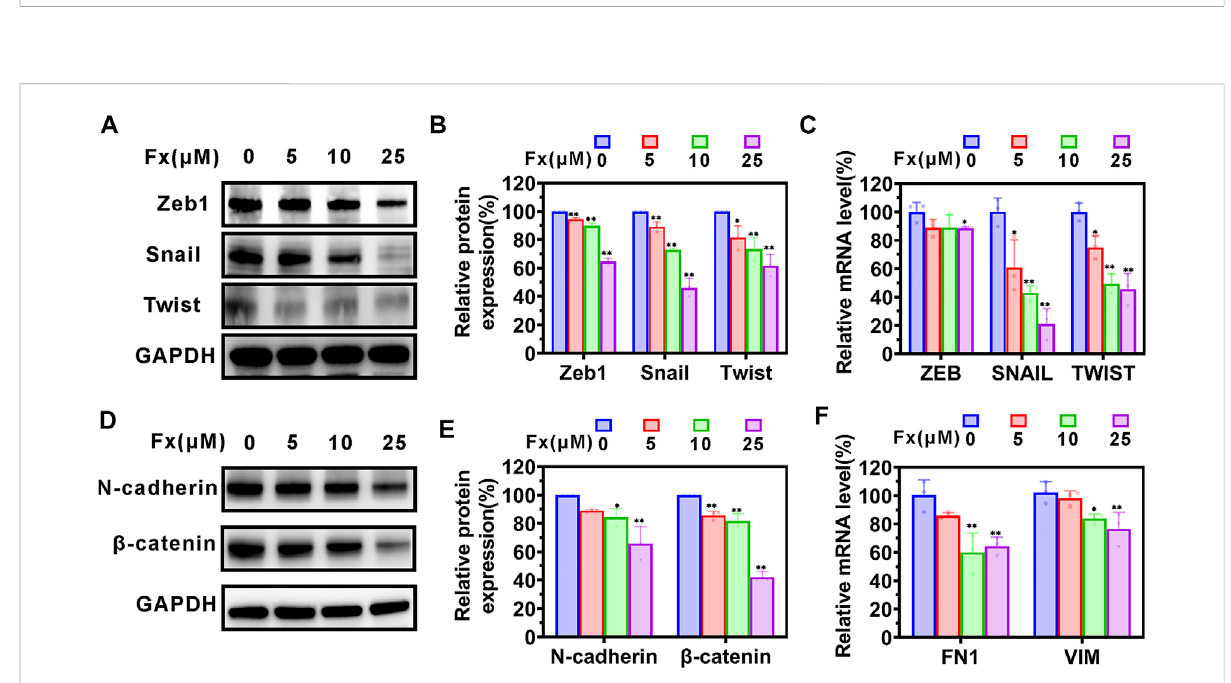
FIGURE 5 The effects of Fx on EMT-related protein in MCF-7 cells. MCF-7 cells were treated with Fx for 24 h, and the expression levels of EMT-related protein andmRNA wereanalyzed by western blot andqRT-PCR,respectively. (A – C) Westernblot and qRT-PCR analysis showed that Fxsigni fi cantly inhibited the expression of EMT transcription factors ZEB, SNAIL, and Twist. (D – F) Western blot and qRT-PCR analysis showed that Fx signi fi cantly inhibited the expression of mesenchymal markers N-cadherin, β -catenin, FN1, and VIM. FN1, fi bronectin; VIM, vimentin. Data are presented as mean ± SD ( n = 3); * indicate p < 0.05, ** indicate p < 0.01 vs . Control (Fx